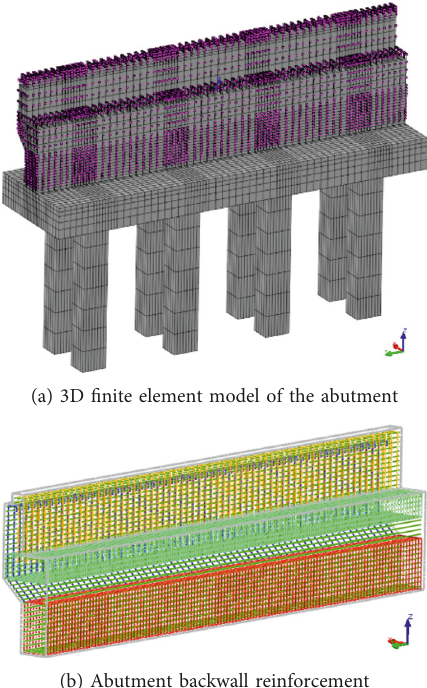
(b) Abutment backwall reinforcement Figure 4: Three-dimensional finite element model of the subject abutment for condition